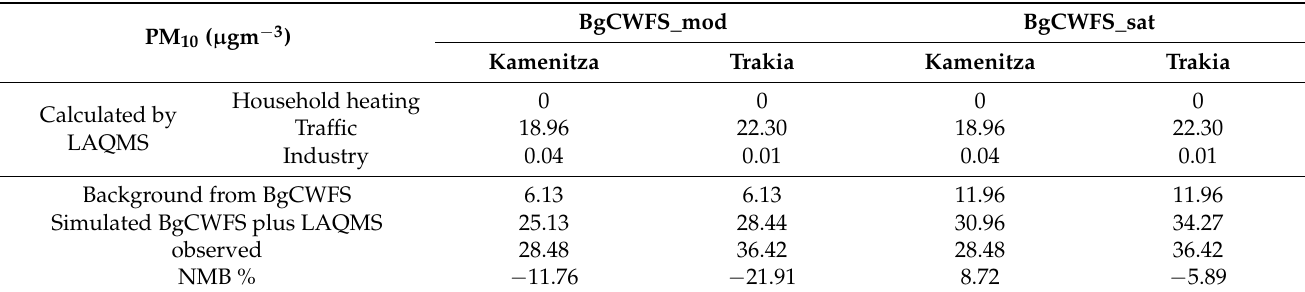
Table 3. Monthly mean PM 10 from LAQMS and (LAQMS + BgCWFS) for August 2017 at AQ stations Kamenitza and Trakia.